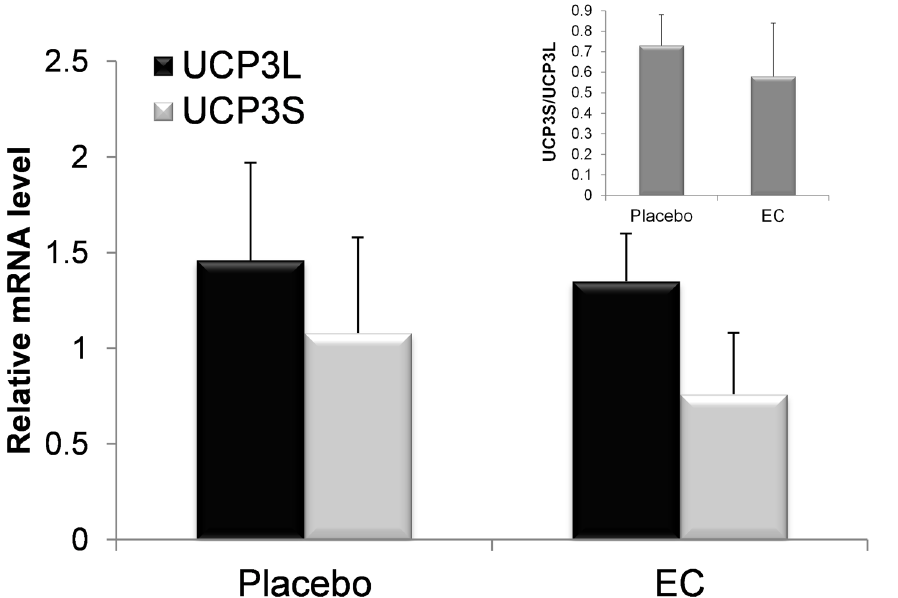
Figure 2. UCP3 isoform mRNA levels in skeletal muscle of placebo- and EC-treated morbidly obese women. UCP3 long (UCP3L) and short (UCP3S) mRNAs were measured by quantitative RT-PCR. mRNA levels were normalized to 18S RNA. n=6 or 7 patients assigned to EC or to placebo, respectively; error bars, s.d. The inset shows the UCP3S/UCP3L mRNA ratio. The PCR experiments were performed twice in triplicate. Data were analysed by unpaired Student’s t test.